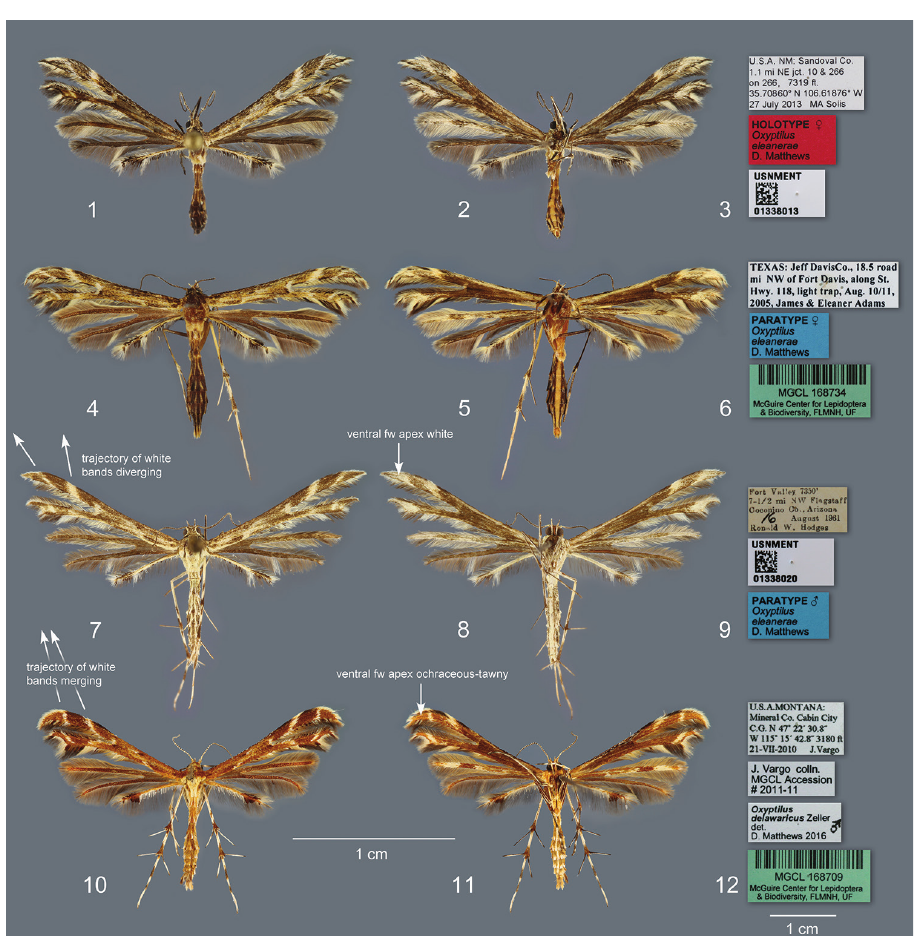
Figures 1–12. Oxyptilus adults and corresponding labels: 1 dorsal view of O. eleanerae , holotype, female, New Mexico, Sandoval County 2 ventral view of holotype 3 holotype specimen labels 4 dorsal view of female paratype, Texas, Jeff Davis County 5 ventral view of female paratype 6 female paratype labels 7 dorsal view of male paratype, Arizona, Coconino County 8 ventral view of female paratype 9 male paratype labels 10 dorsal view of male O. delawaricus , Montana, Mineral County 11 ventral view, same individual 12 specimen